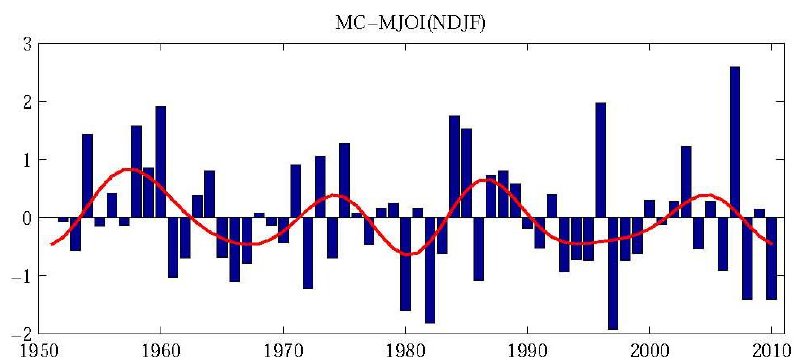
Figure 4. Yearly MC–MJO kinetic energy index in winter (bar). Results after nine point low pass filter are given in the red dashed line.